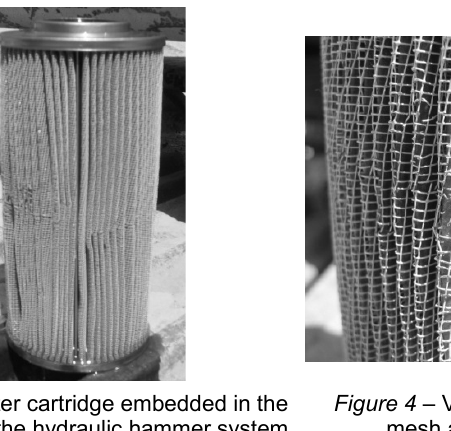
Figure 4 – Visible damage in the steel mesh and the filter medium Slika 4 – Vidljiva ošte ć enja na č eli č noj mrežici filterskog